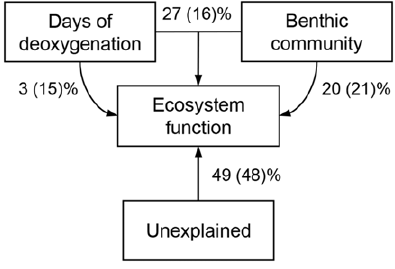
Figure 5. Partitioning of the variation in ecosystem function between the benthic community and the duration of hypoxia. Ecosystem functioning was defined as all chemical fluxes, while the benthic community was described in terms of number of species, evenness, number of trait modalities, average number of species per trait modality, total abundance and total biomass. The variances explained when the 48-day treatment is excluded are within parenthesis.